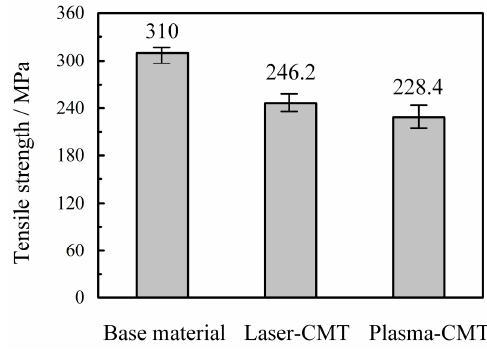
Figure 9. Tensile strength of base materials, laser-CMT, and plasma-CMT hybrid welded joints.